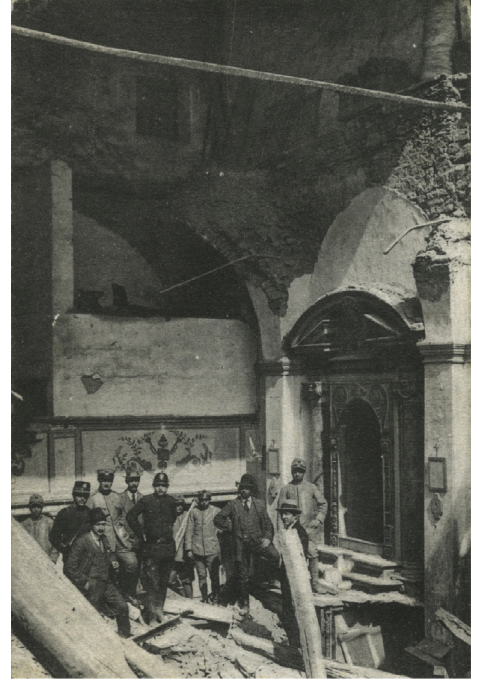
Figure 2. The very ancient church of San Giacomo of Citerna heav- ily damaged by the earthquake of April 26,